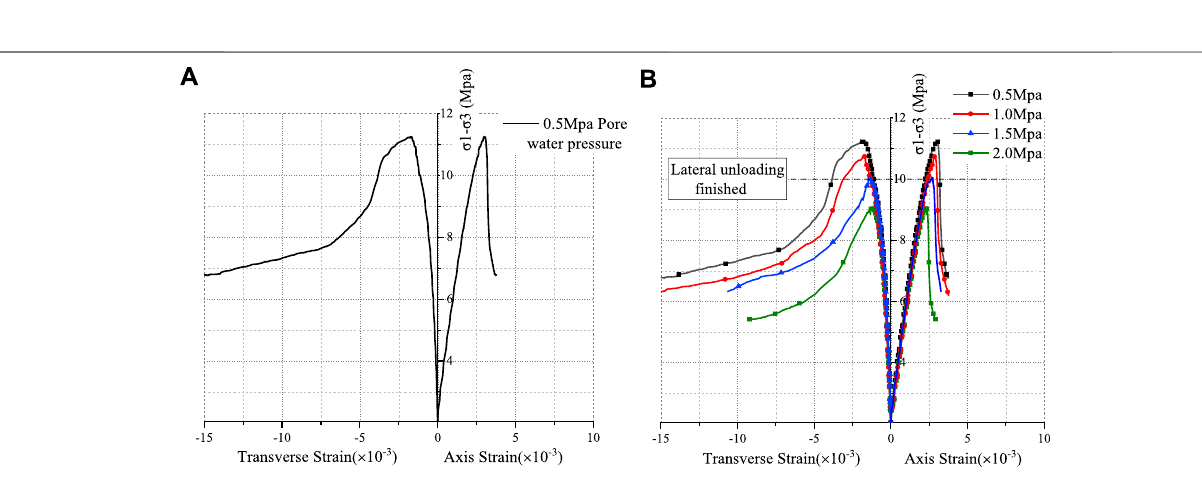
Frontiers in Earth Science |